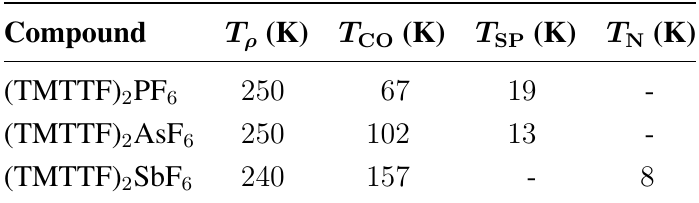
and charge order T of various ρ CO is the N